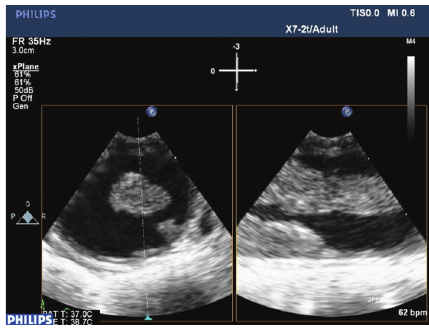
Figure 2: Two-dimensional transesophageal echocardiogram (2D TEE) X-plane images demonstrating two aortic thrombi.